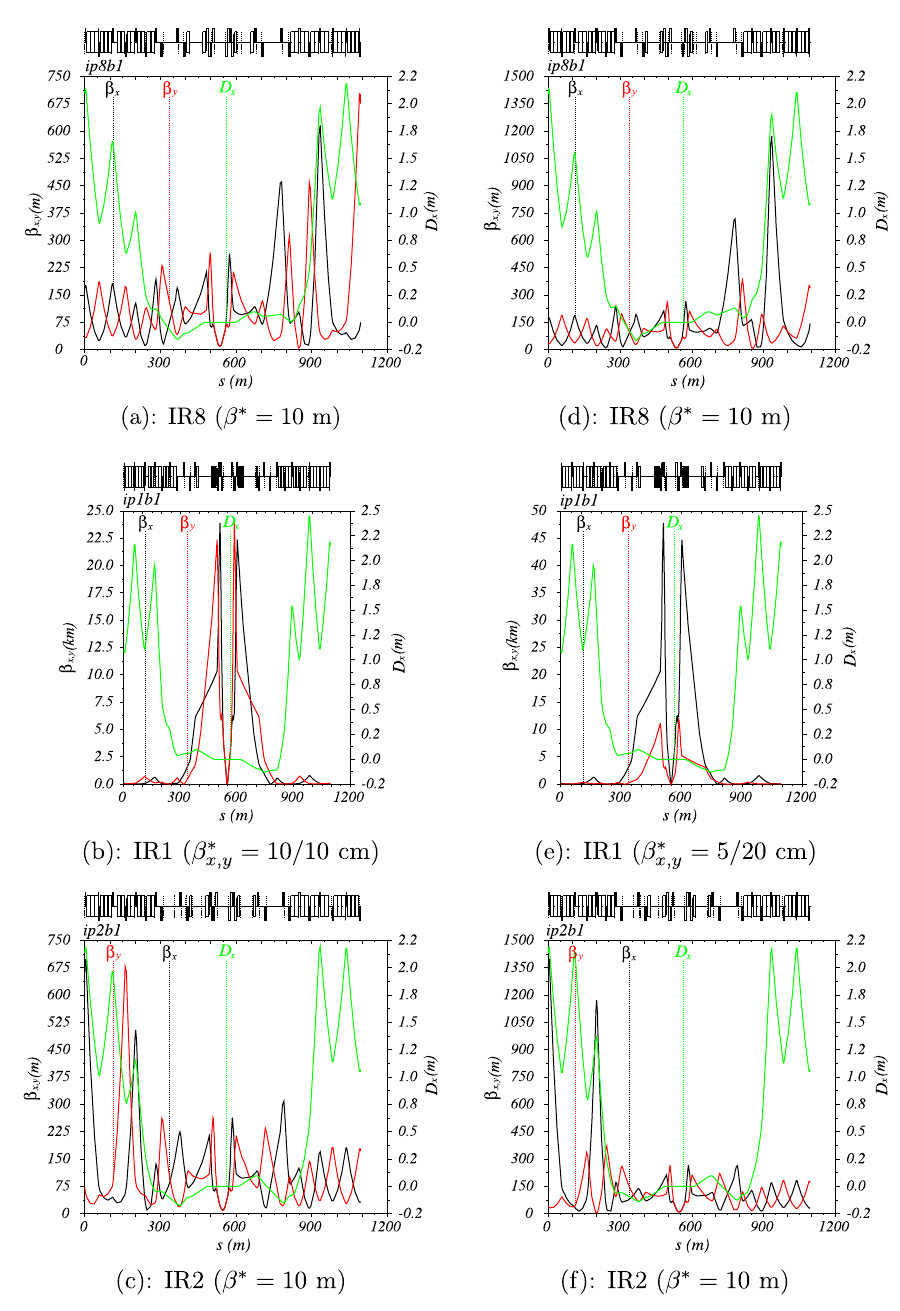
FIG. 8. Round (left pictures) and flat (right pictures) telescopic optics zoomed in IR8, IR1, and IR2, with (cid:1) (cid:1) x;y ¼ 10 = 10 cm and = 20 cm at IP1, respectively. The peak (cid:1) functions reached in the triplets of IR1 amounts to about 25 km in the first case (b), (cid:1) (cid:1) x;y ¼ 5 and up to 50 km in the second case (e). All these optics are shown with the crossing scheme switched off in IR1, IR2, IR5, and IR8 in order to preserve the dispersion matching (see also Sec. III